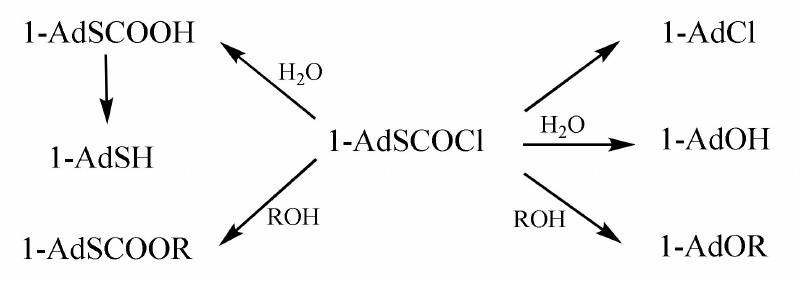
Table 5. Effect of added tetraethylammonium chloride (Et 4 NCl) upon the rate constants of reaction and percentage of reaction with solvolysis for reaction of 1 a in ethanol at 25.0 ◦ C. % Composition as a Function of X in 1-AdX b